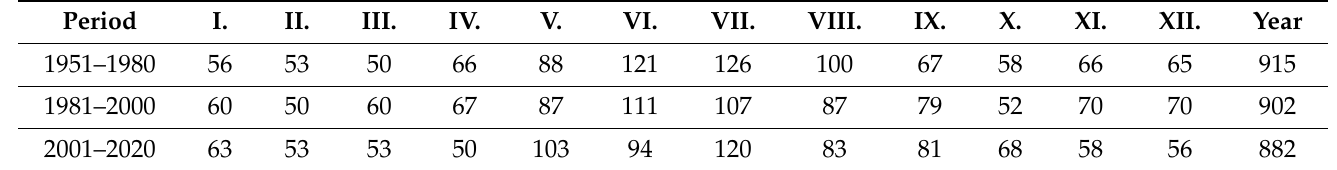
Table 2. The average monthly temperature in ˇCadca for the period 1951–2020 (SHI). Period I.